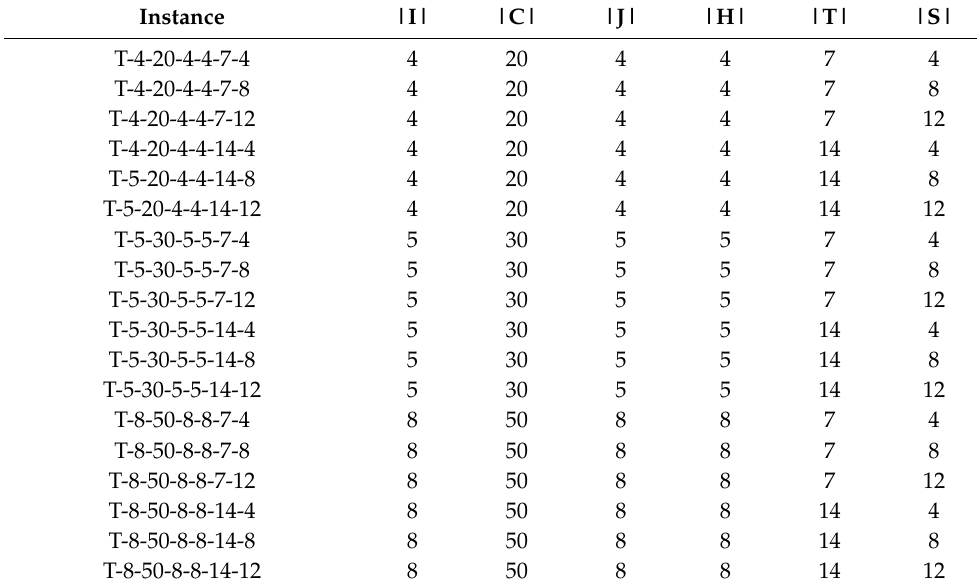
Table 10. Parameters of the test instances.